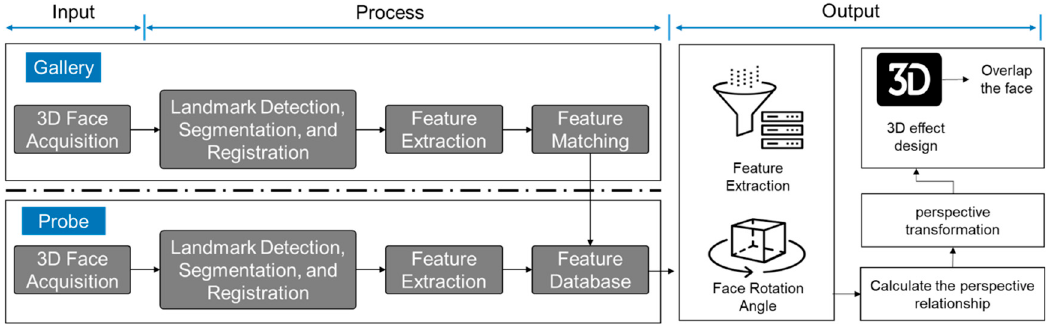
Figure 4. System-wide process for interview management. 3.1. Image Multi-Block Process for Face Main Point Extraction